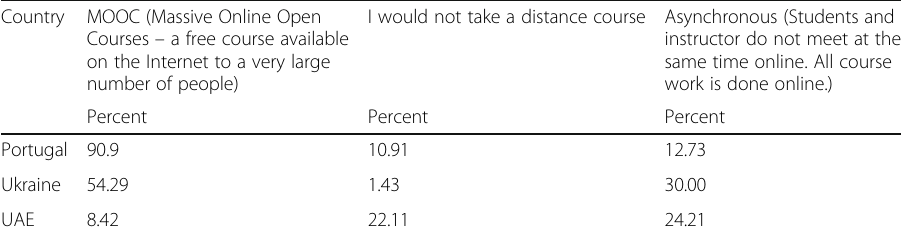
Table 10 Types of distance education interested in trying (More than one could be chosen) Country MOOC (Massive Online Open I would not take a distance course Asynchronous (Students and Courses – a free course available instructor do not meet at the on the Internet to a very large same time online. All course number of people) work is done online.)